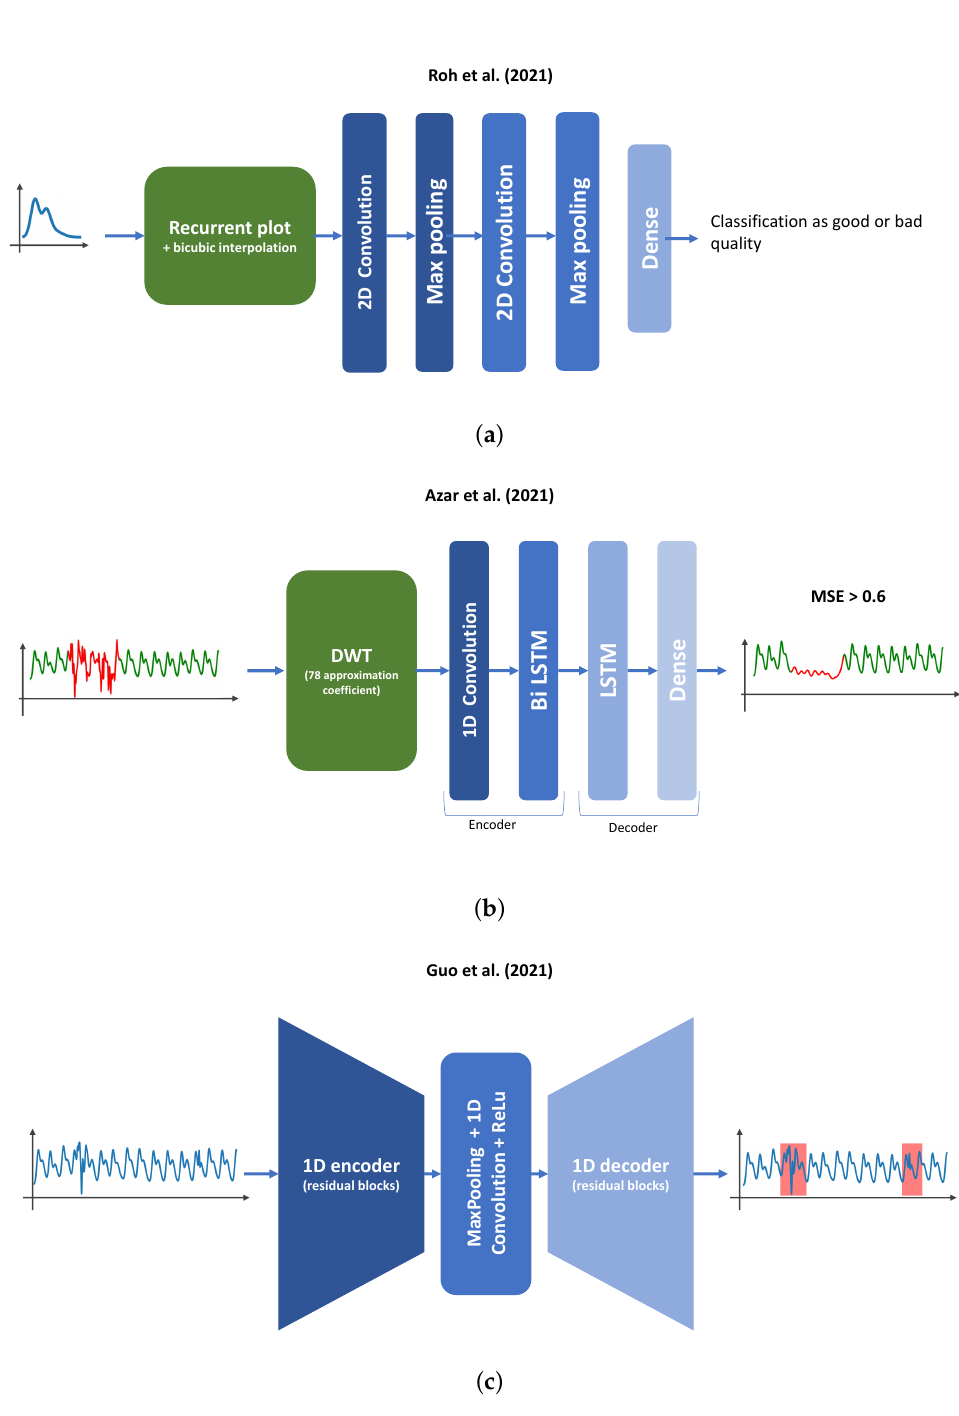
Figure 7. Presentation of several deep learning architectures dedicated to quality estimation of a cPPG signal. ( a ) Architecture used by Roh et al. [54] using 2D convolution to treat each pulse of the signal as an image. ( b ) Architecture implemented by Azar et al. [92]. Because the architecture is only trained on clean PPG signals, it will fail to reconstruct a PPG signal when the input is corrupted, thus increasing the MSE between the reconstructed signal and the input signal. With a manually chosen threshold, it allows one to make the distinction between good and bad signal quality. ( c ) Architecture implemented by Guo et al. [56] showing the estimation of the quality of the signal as a segmentation problem using deep